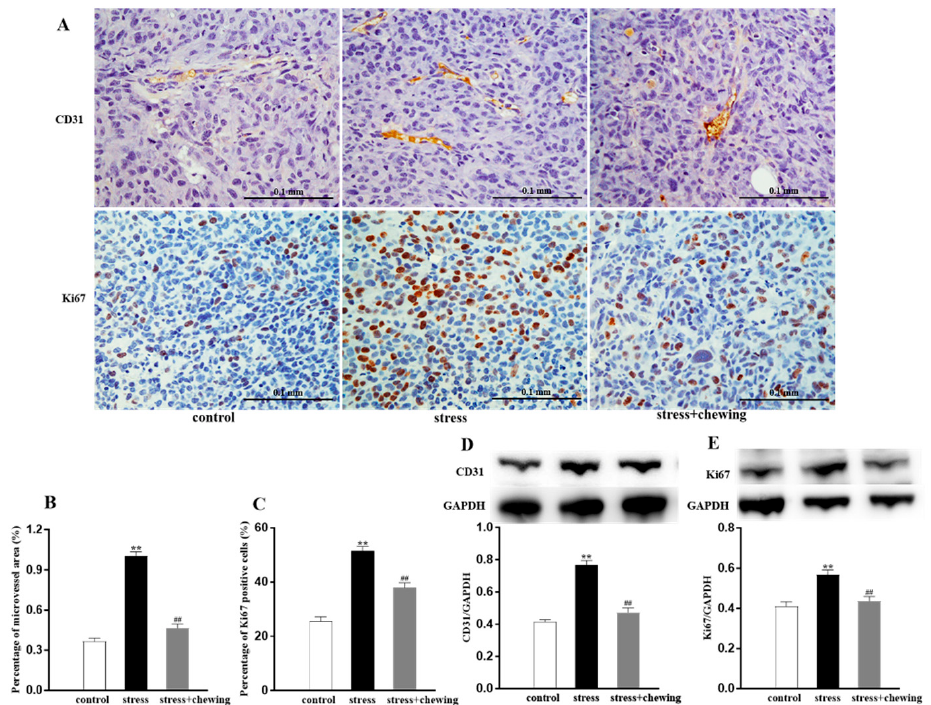
Figure 2. Chewing behavior during psychological stress alleviated tumor angiogenesis and proliferation. ( A ) Representative photographs of CD31-positive cells and Ki67-positive cells in the tumor. ( B ) The percentage of microvessel area in the tumor. ( C ) The percentage of Ki67-positive cells in the tumor. ( D ) The expression level of CD31 in the tumor. ( E ) The expression level of Ki67 in the tumor. (** p < 0.01 vs. control group, ## p < 0.01 vs. stress group, n = 9/group). All data are expressed as mean ± SEM.